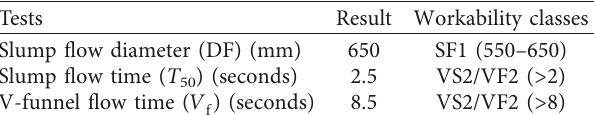
Table 2: Workability characteristics of self-compacting concrete (SCC).